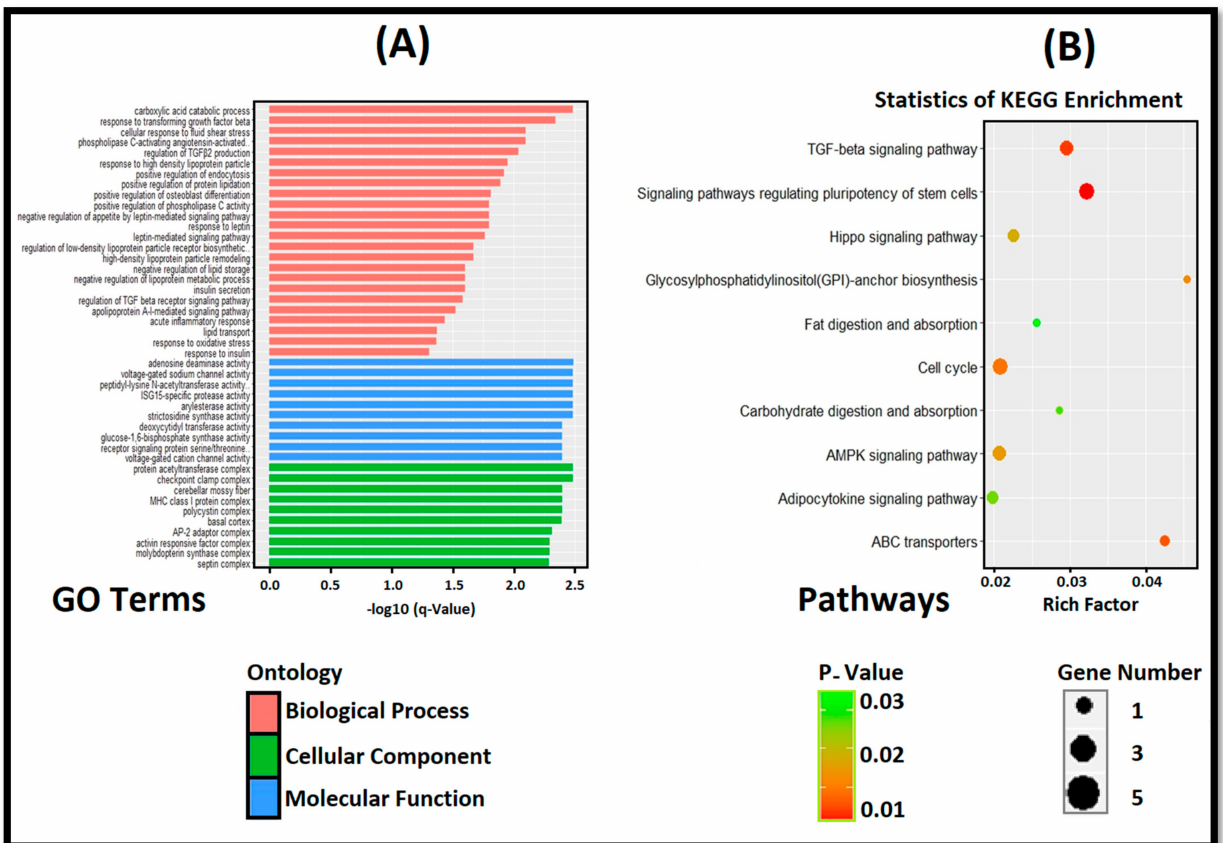
Figure 5. Functional enrichment analysis of host genes ( A ) shows the GO analysis for host genes of DECs; ( B ) demonstrates the KEGG pathway enrichment analysis for host genes of DECs. Note: the names of the pathways are shown on the Y -axis and the enrichment factor on the X -axis. The sizes and colors of the circles represent the quantity and significance of DEC-enrichment in a certain